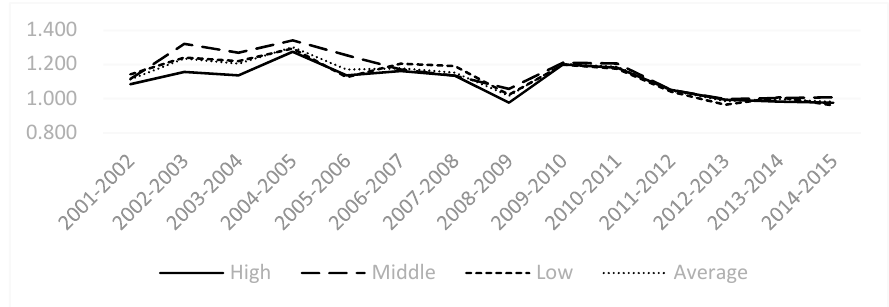
Figure 3. Malmquist index of China’s high-polluting industry 2001–2015. Table 5. 2001–2015 Malmquist index of high-polluting industry and its breakdown.